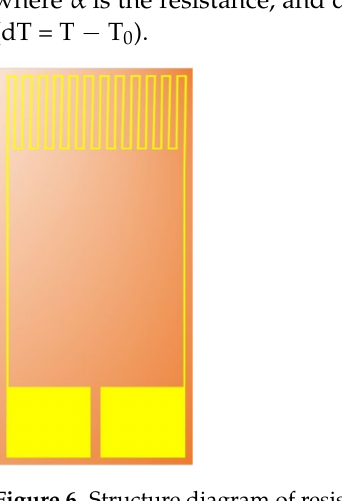
Figure 6. Structure diagram of resistance micro-temperature